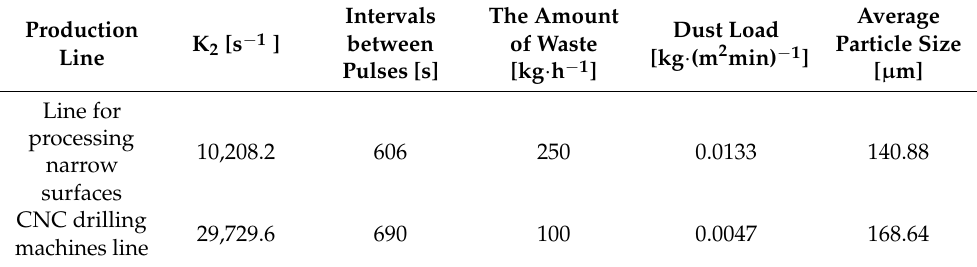
Table 7. Working conditions of bags in industrial installations and results of the dust resistance coefficient K 2 .